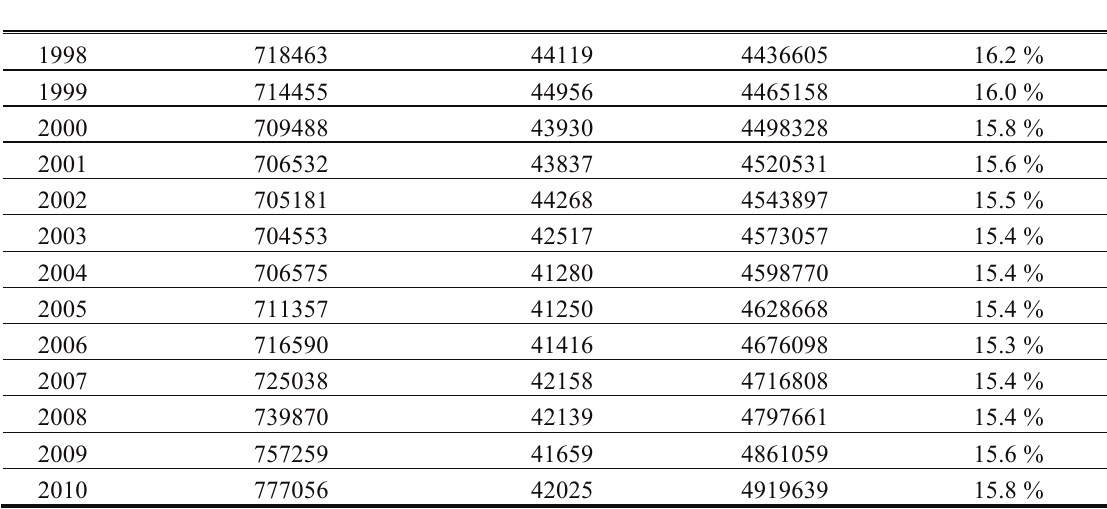
Table 1: Demographic